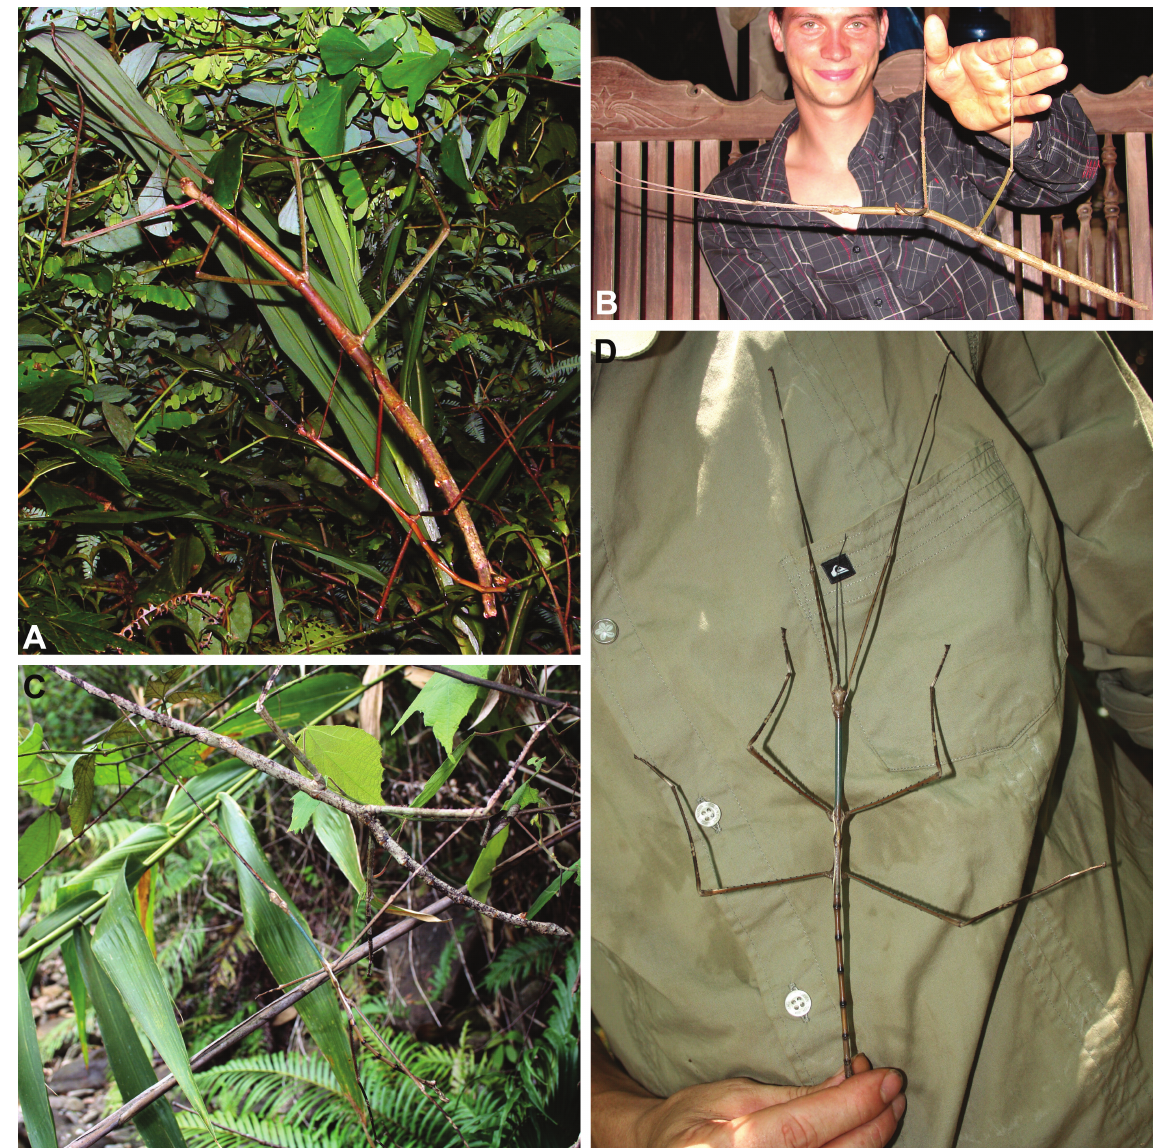
Fig. 11. Photographs in natura by the authors. — A–B . Phryganistria heusii yentuensis subsp. nov . A . Mating pair. B . The first author with the 31.7 cm long ♀, Tay Yen Tu N.R., 9 Jul. 2013. — C–D . Phobaeticus trui sp. nov. C . ♂ and ♀, Bach Ma N.P., 13 Jul. 2013. D . ♂, Da Krong N.R., 7 Jul.